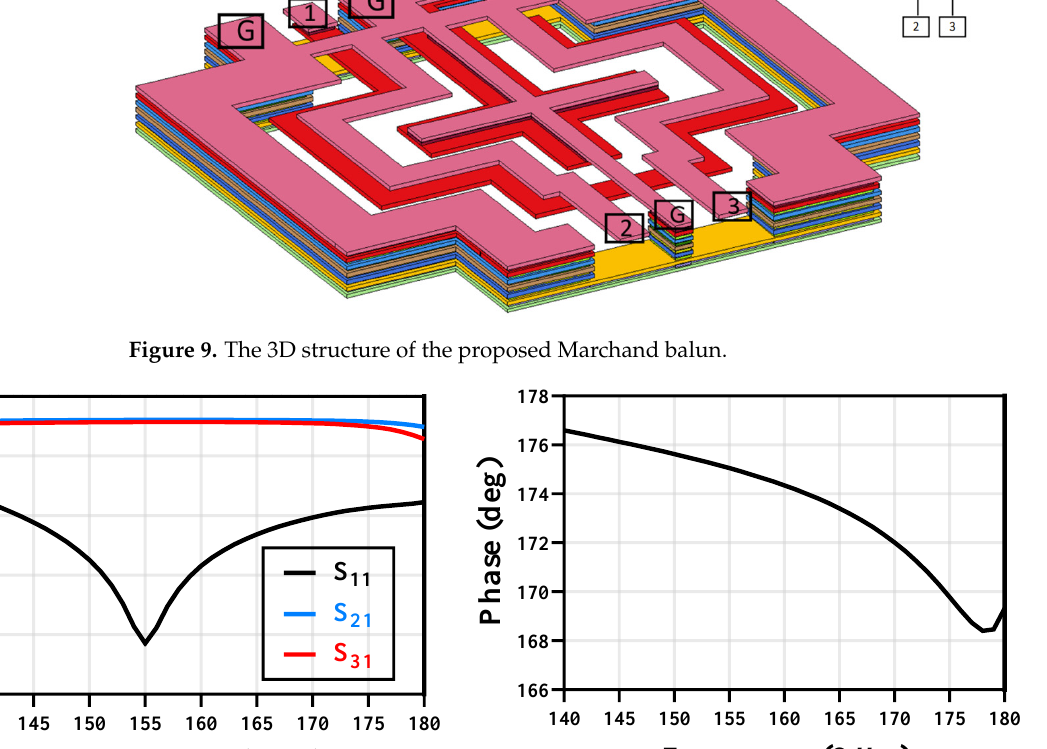
Figure 10. The EM simulation results of the Marchand balun: ( a ) S − parameters; ( b ) phase imbalance.